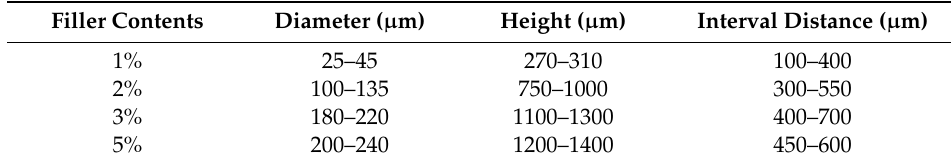
Figure 6. Typical array of vertical protrusive Shape Memory Polymer/Nickel (SMP/Ni) chains with varied volume fraction of nickel particles: 1%, 2%, 3%, and 5%. Table 1. Dimensions (diameter, height, and interval distance) of vertical Shape Memory Polymer/Nickel (SMP/Ni) chains.